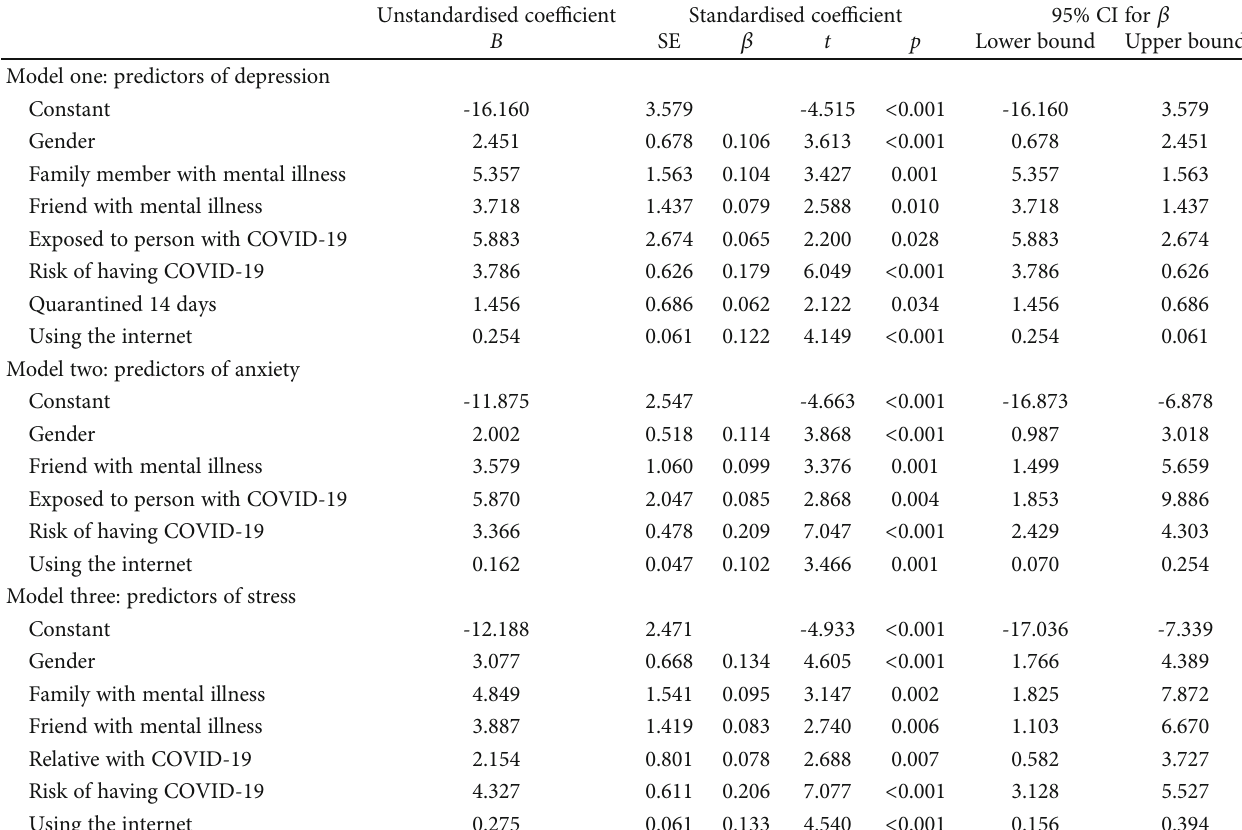
Table 4: Linear regression model of independent variables that predict depression, anxiety, and